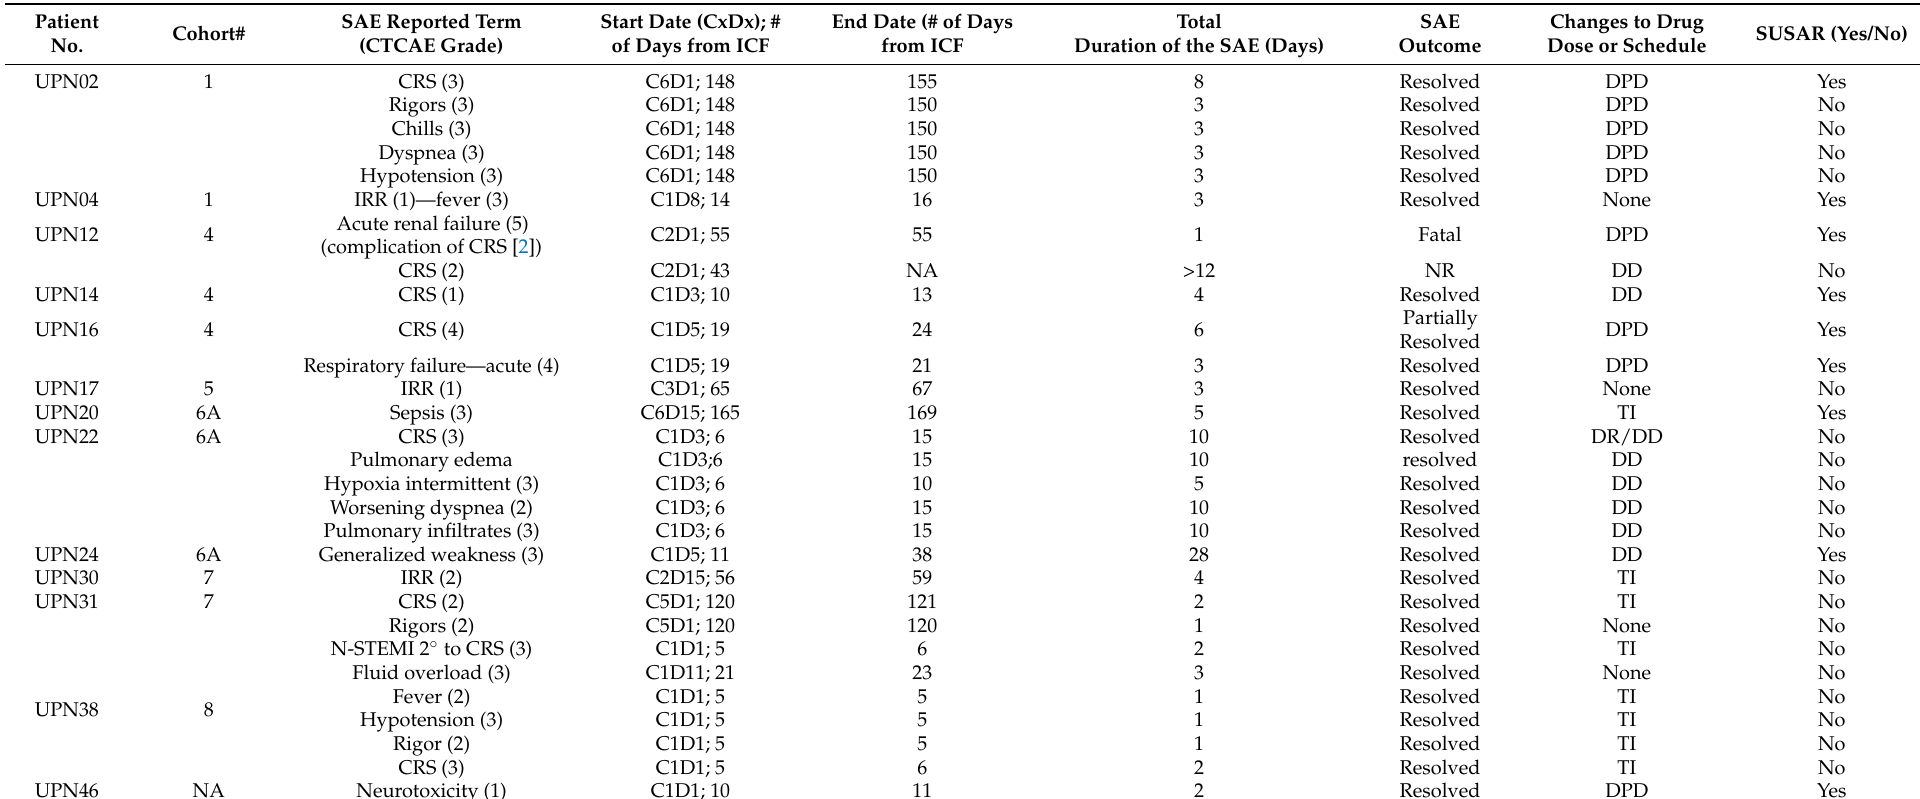
Table 3. Listing of all APVO436-related serious adverse events